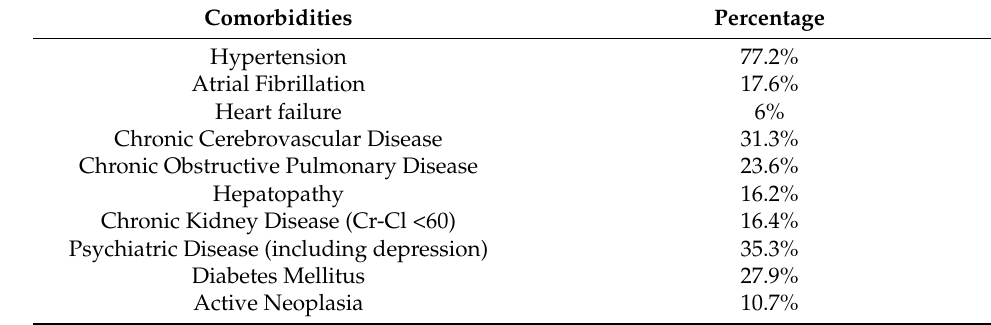
Table 2. Distribution of the major